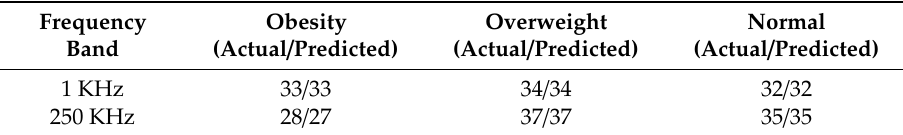
Table 2. Classification of the test data with the iSVM.